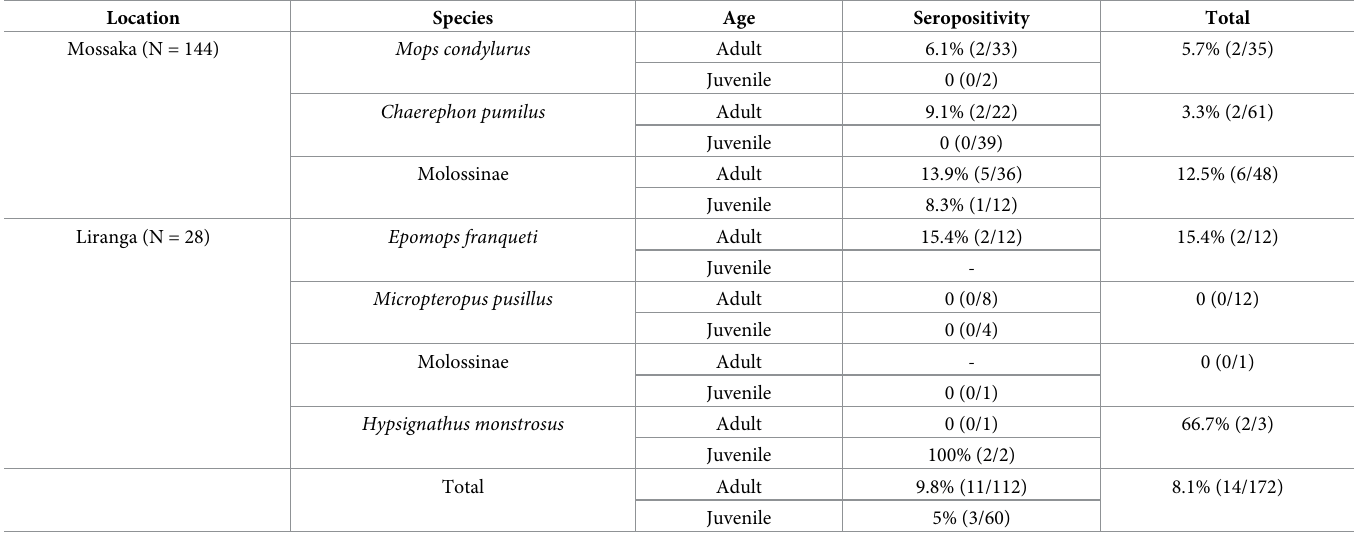
Table 1. Serological status (IgG) against EBOV glycoprotein in bats sampled in ROC near the Bikoro, DRC, Ebola virus disease outbreak in 2018.